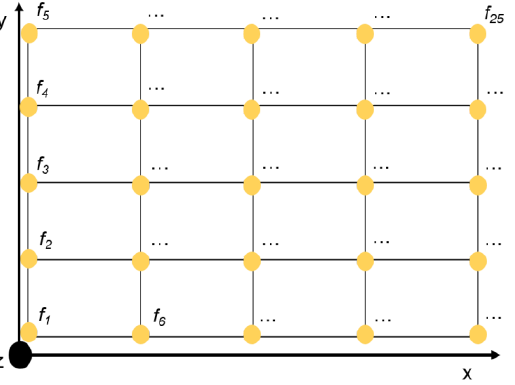
Figure 2. Top view of the surface on the example of a 5 × 5 resolution for 𝑧 = 𝑓(𝑥, 𝑦).